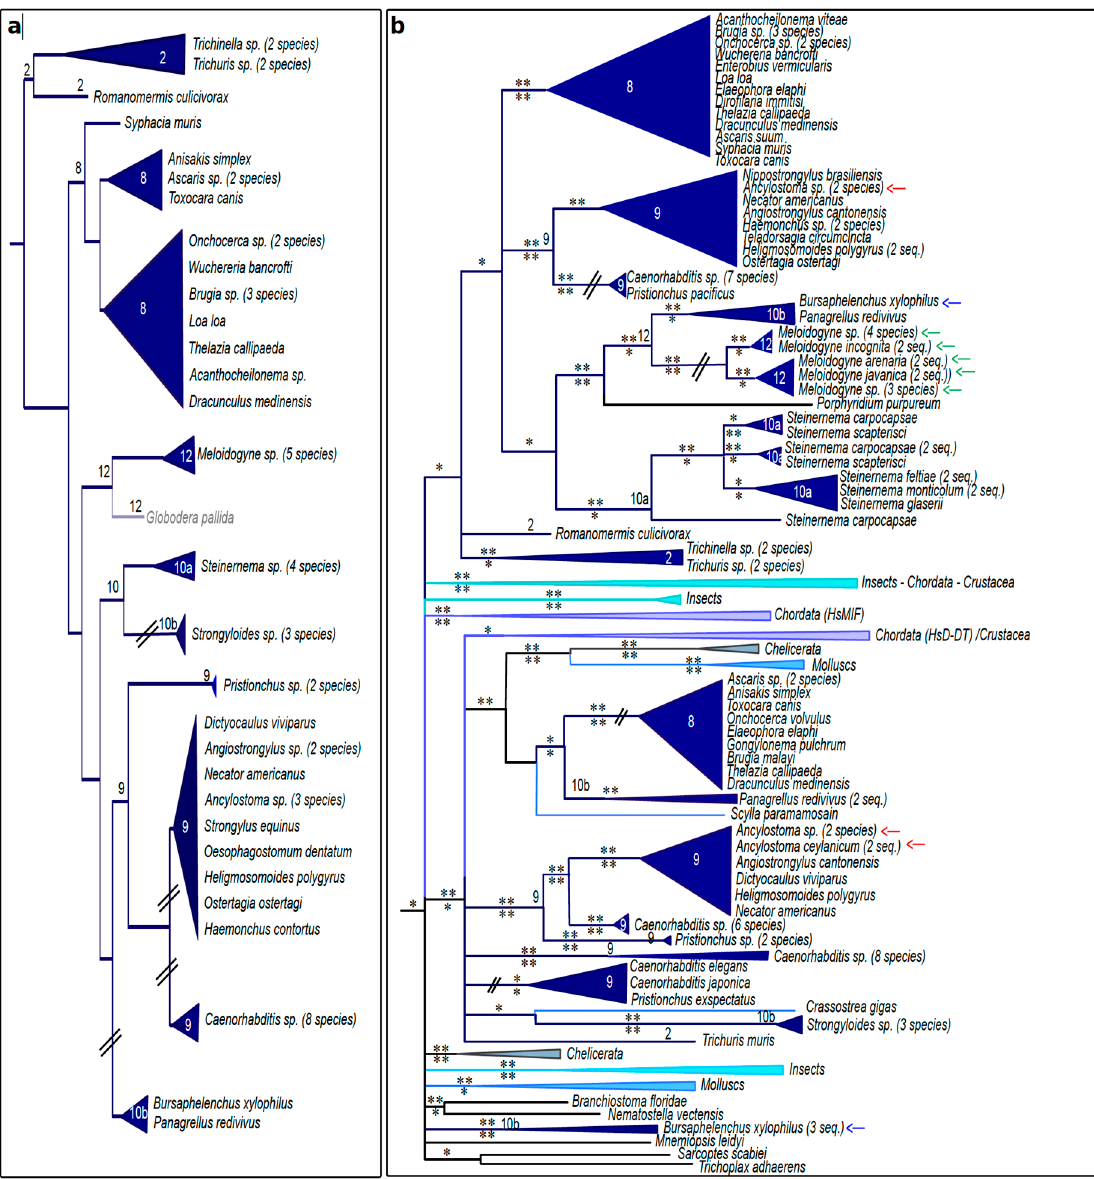
Figure 4. Nematode species tree and corresponding MIF phylogeny. ( a ) BI tree topology based on nematode 18S rRNA sequences. The nematode Clade numbers [59] are indicated at the corresponding branches for ease of results interpretation. The cyst nematode Globodera pallida , lacking any MIF protein sequence, is shown in grey. ( b ) BI tree topology for MIF sequences of the same species. Colors of MIF clusters are given according to the taxonomy, as indicated in Figure 2. MIF from three of the species commented in the text are indicated by arrows ( Ancylostoma in red, Meloidogyne in green and Bursaphelenchus in blue). PP support values are indicated above the branch for the BI and corresponding aLRT support values below the branch for the ML analysis. *: PP > 0.5 or aLRT > 0.7. **: PP > 0.7 or aLRT > 0.9. The corresponding tree using the ML method is presented in Supplementary Figure S5a.